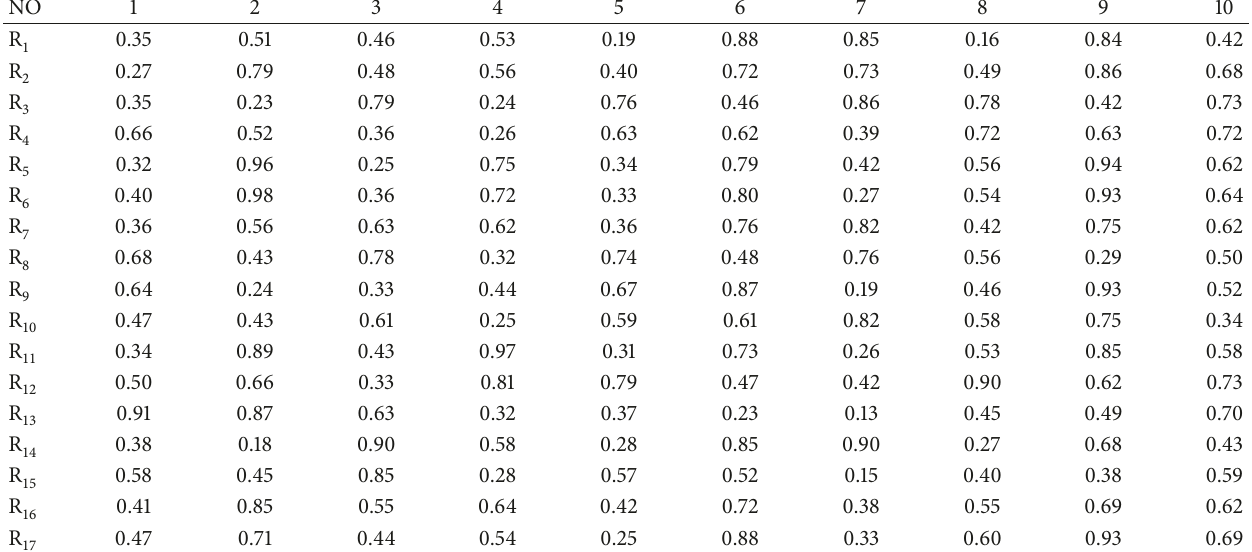
Table 12: Interfered data in the top 10 countries in Europe.